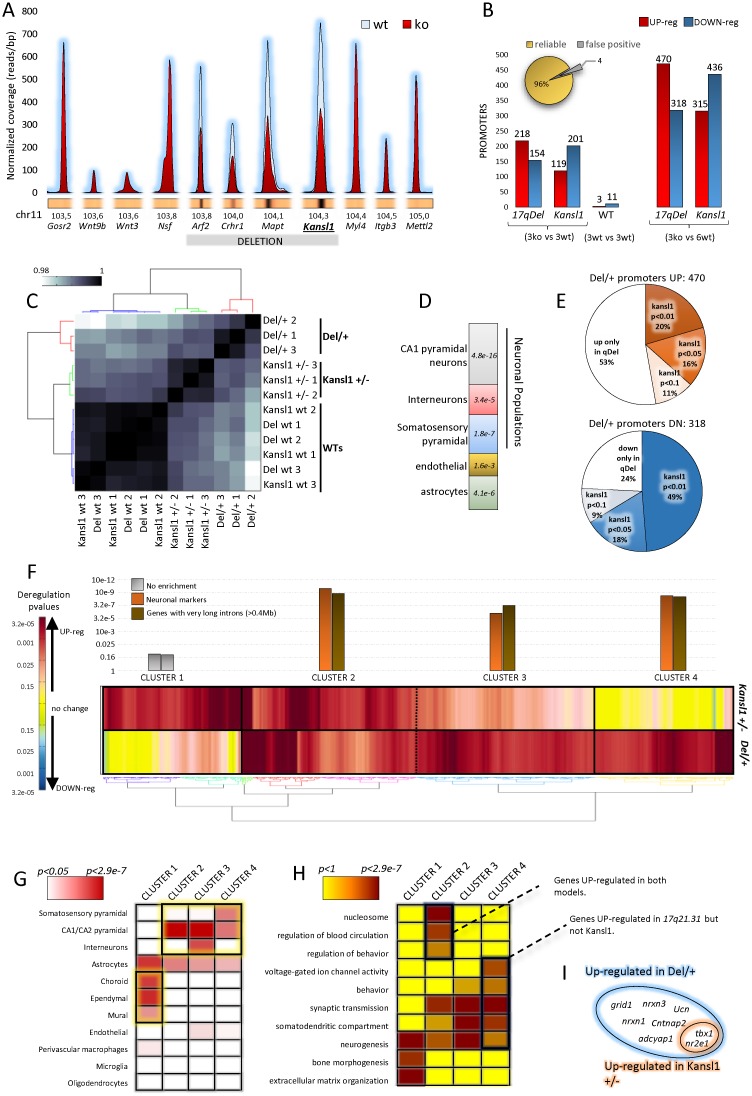
Epigenetic profiling in the hippocampus of KdV mouse models demonstrated non-neuronal and neuronal cell-specific alterations.(A) H3K4me3 pattern in the deleted region and its flanking sequences. Graph with a schematic representation of H3k4me3 peaks (averaged over three biological replicates) at the promoters of the genes in the 17q21.31 deleted region and flanking regions. Peaks within the deletion show half intensity as compared to wt, while peaks in the surrounding regions show the same intensity and patterning, thus confirming the absence of nonspecific-effects. (B) Overview of promoter deregulations. For each mouse model (Kansl1+/- or Del/+) 3 wt biological replicas and 3 mutant biological replicas were generated for H3K4me3 ChIP-seq. DEseq2 algorithm was used to call the significant deregulations (P value<0.01) in the promoters. False positives, as detected by comparing the two groups of WT samples, can be estimated to only 4%. Given that no consistent changes were found among WT sets we opted to collapse all the 6 wts in one group and use it as the common control for both Kansl1+/- and Del/+ samples, thus increasing the sensitivity and detecting more dysregulation (right histograms) (C) Clustering of Pearson correlation calculated over the total dysregulated promoters clearly segregates the different conditions. (D) Cell types of Del/+ up-regulated genes. The Stacked histogram represents the enrichment of cell-type specific markers in the Del/+ UP-regulated genes. The strongest enrichment is for CA1 pyramidal neurons markers, followed by genes specific to somatosensory cortex pyramidal neurons, astrocytes and interneurons. A milder, but still significant, enrichment was found for endothelial cells. Together, these results suggest that Del/+ deletion causes perturbations that are cell-type specific. (E) Overview of Del/+ misregulation in the Kansl1+/- model. Pie charts summarize the behavior of Del/+ deregulated genes in the Kansl1+/- model to evaluate the extent to which Kansl1 alone is able to mimic the Del/+ misregulations. To better describe the shades of gray always inherent to the P values, we classified the strength of Kansl1+/- deregulation in four classes, ranging from no-change to the same intensity of Del/+. We could not detect any ‘reversal’ in the deregulations (i.e. genes up-regulated in one mutant being down-regulated in the other and vice versa) (E) Clustering of the Del/+ and Kansl1+/- deregulated genes. The heat map includes all the genes that are significantly UP-regulated in either of the models. Enrichment of neuronal markers are based on published work. (F) Study of cell-type markers. The heat map represents the significance of the enrichments for specific markers in the 4 different clusters of section E. (G) Study of Cluster GO enrichments. The heat map represents the significance of the GO enrichments in the 4 clusters of section E. (I) overview of social behavior genes.